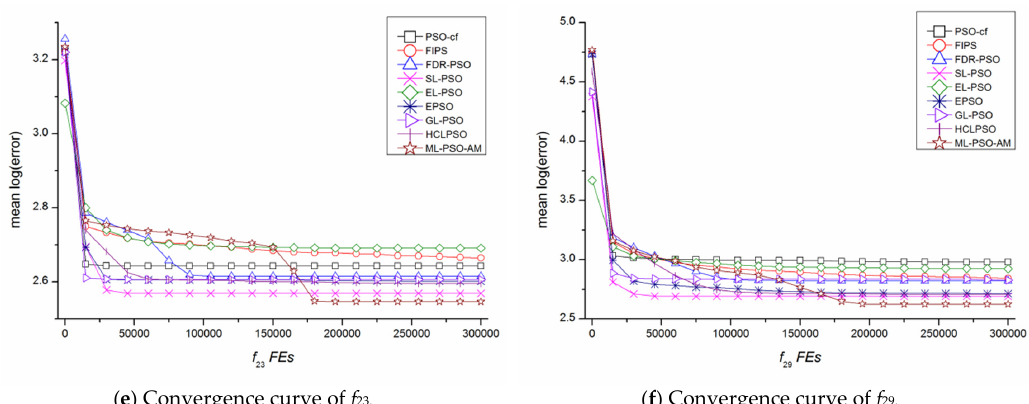
Figure 2. Convergence curves of the representative functions.